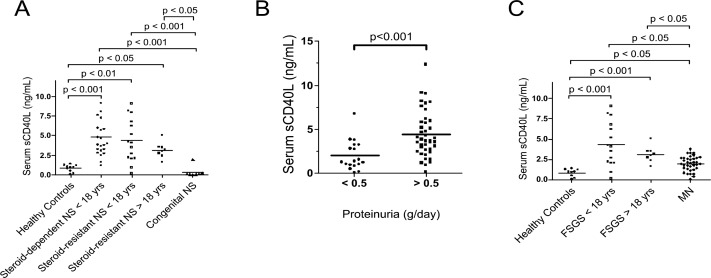
sCD40L concentrations in serum samples from children and adult patients with idiopathic nephrotic syndrome and from healthy subjects.(A) Serum sCD40L levels in healthy controls and in patients with idiopathic nephrotic syndrome (NS), subdivided according to clinical features (i.e. age at onset and response to steroids). Baseline clinical characteristic of the patients with idiopathic nephrotic syndrome are reported in Table 2. Children who presented proteinuria under the 1st year of age underwent biopsy and had a diagnostic molecular approach for several genes implicated in NS; they were classified as congenital NS (cNS). (B) Serum sCD40L levels in healthy controls and in patients with steroid-resistant idiopathic nephrotic syndrome according to the levels of proteinuria (< or > 0.5 g/day). (C) Serum sCD40L levels in patients with nephrotic syndrome and a biopsy-proven diagnosis of FSGS or of iMN. Patients with FSGS were further subdivided according to their age in < or > 18 years. Patients with iMN were always older than 40 years.All patients had eGFR >60 ml/min at the time of serum sampling for sCD40L measurement.